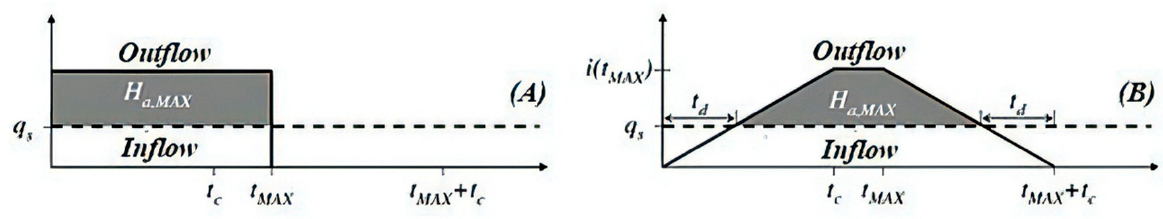
Figure 4. ( A ) Dutch method; ( B ) STH method (Source: